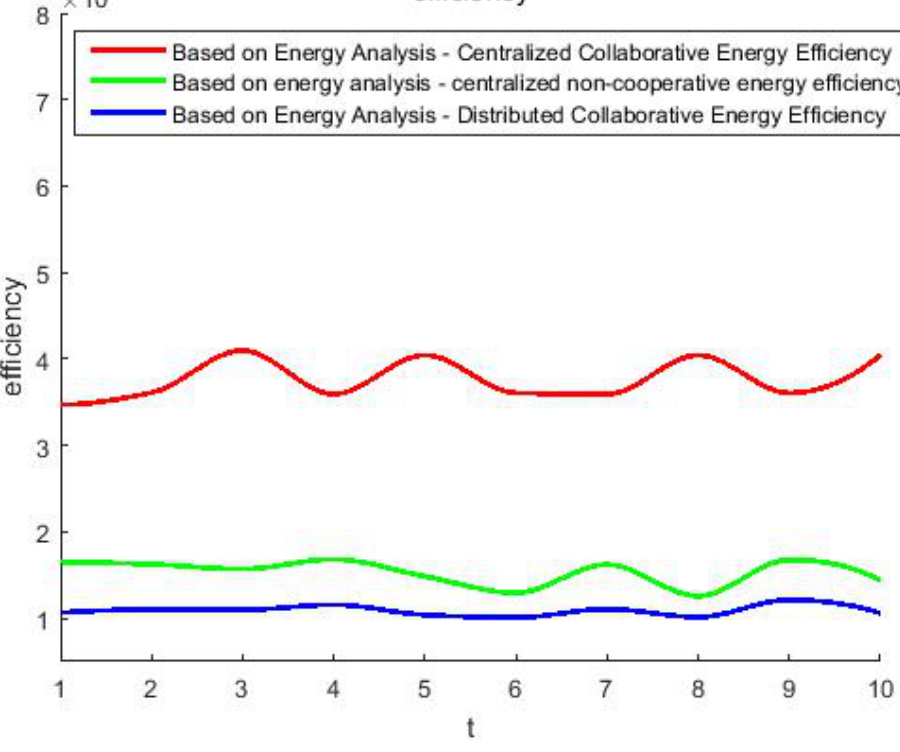
Figure 10. Energy efficiency under different energy analysis-sensing methods.